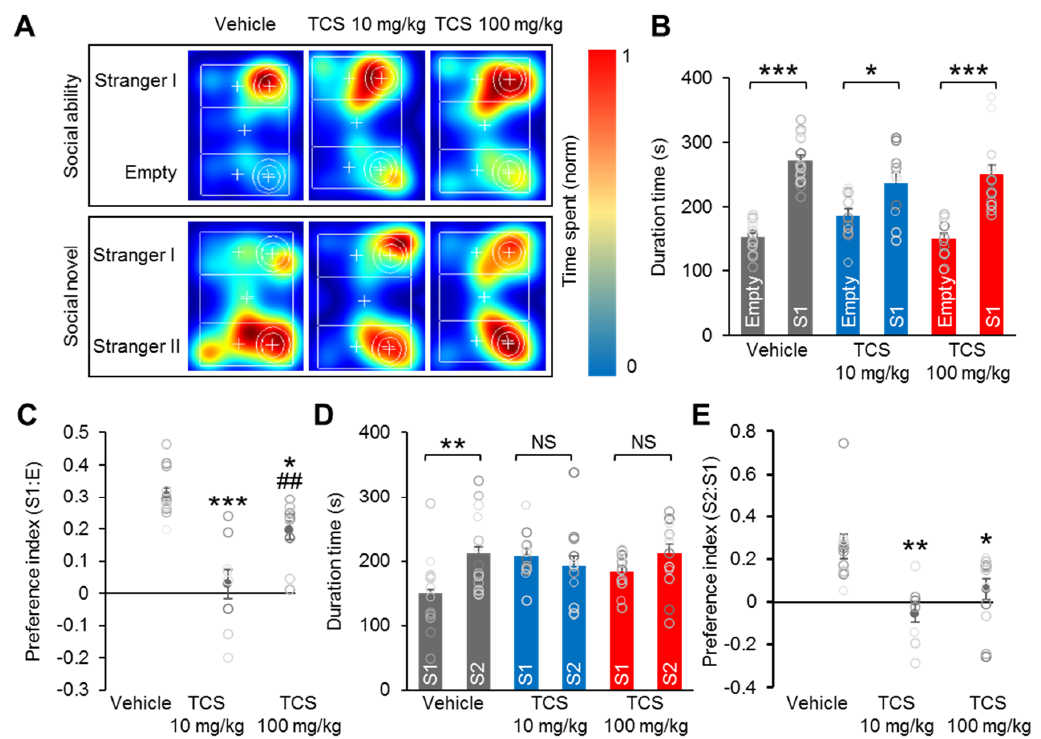
Figure 4. TCS mice display social behavioral alteration in three-chamber tests. ( A ) Representative heat map images from ‘Stranger I–Empty’ and ‘Stranger I–Stranger II’ from social ability and novel tests. ( B , C ) Quantification of A for sociability test. TCS-treated groups interact with ‘Stranger’ stimulus mice. Both vehicle and TCS-treated groups display preference for the chamber containing an unfamiliar mouse ‘S1′ than in the empty chamber, but the TCS-treated group preference index was significantly reduced compared to vehicle group. ( D,E ) Quantification of A for social novelty test. TCS-treated groups showed no preference for a stranger mouse ‘S2′ over a familiar mouse ‘S1′ and lower index of preference for the novel stimulus than in vehicle group. Data represent mean ± SEM. Statistical stranger I and stranger II for each group and condition by a two-tailed Student’s t test. For preference index, statistical significance was determined by one-way ANOVA with Bonferroni correction. * p < 0.05 and ** p < 0.01 vs. vehicle, *** p < 0.001 vs. vehicle, ## p < 0.01 TCS 10 mg / kg vs. TCS 100 mg / kg. NS, no significance. n = 18 mice (7 male, 11 female) for vehicle, 11 mice (8 male, 3 female) for TCS 10 mg / kg, 17 mice (10 male, 7 female) for TCS 100 mg / kg. Treatments: corn oil; vehicle, TCS; 10 mg / kg / day, TCS; 100 mg /